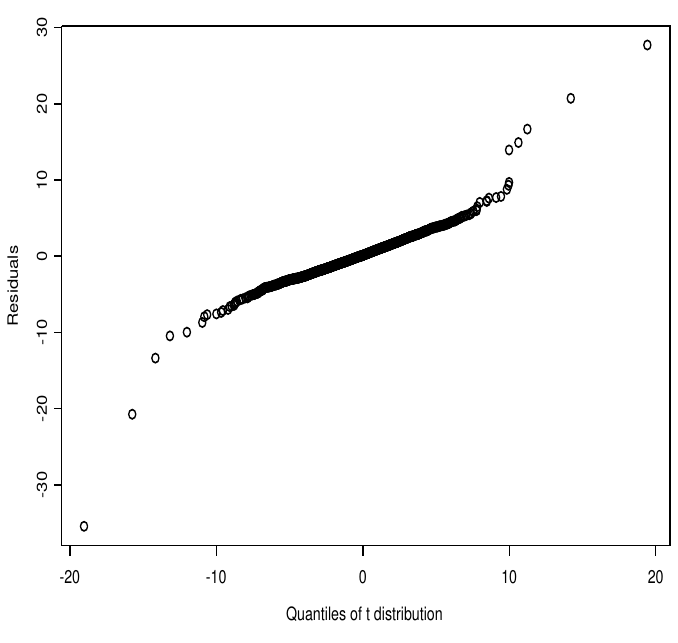
Figure 9. QQ-Plot of GARCH Residuals.